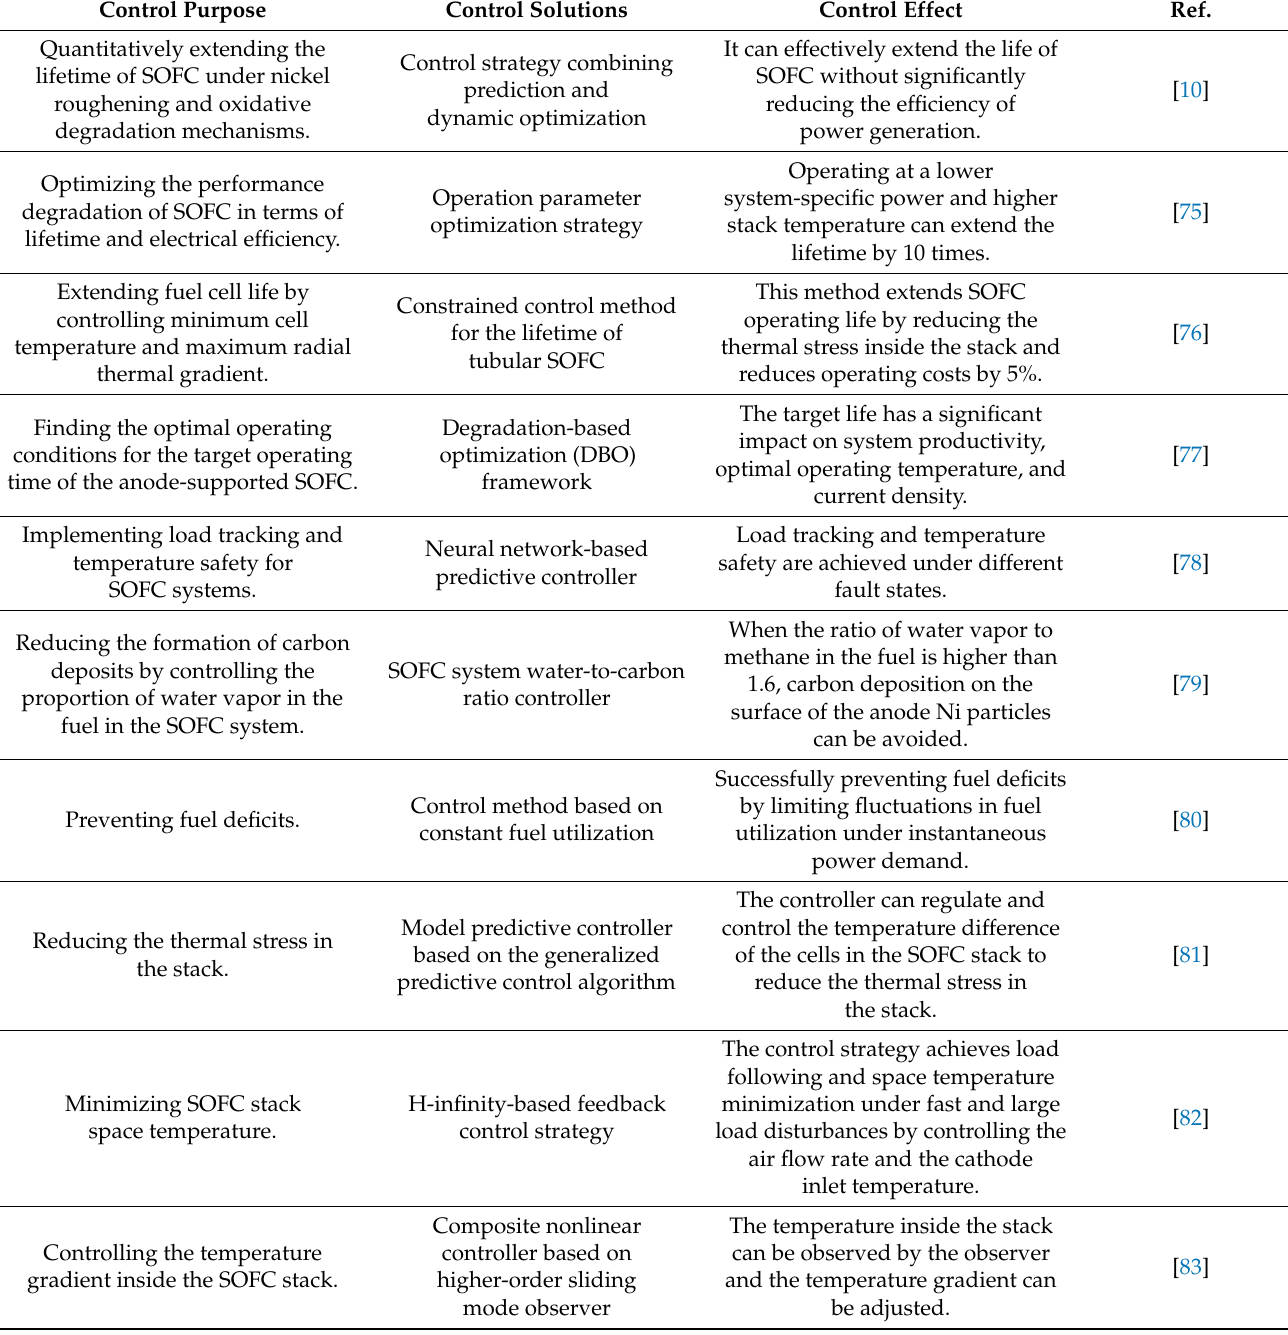
Table 6. SOFC system health controller design